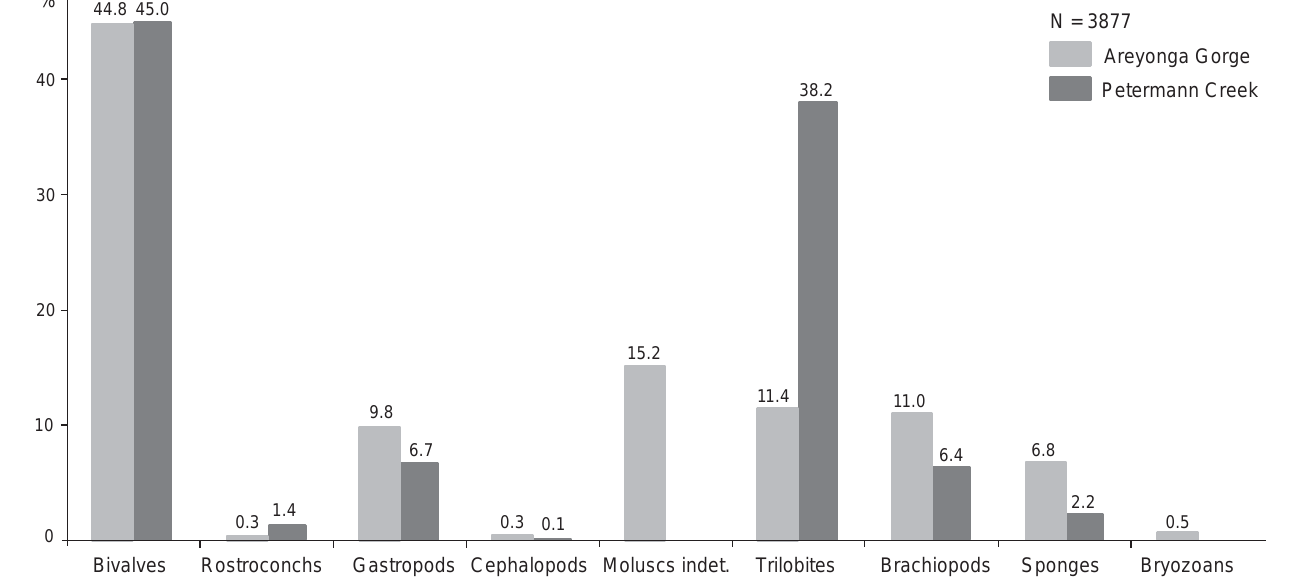
Fig. 9. Diversity of entire shelly fauna in the Areyonga Gorge and Petermann Creek